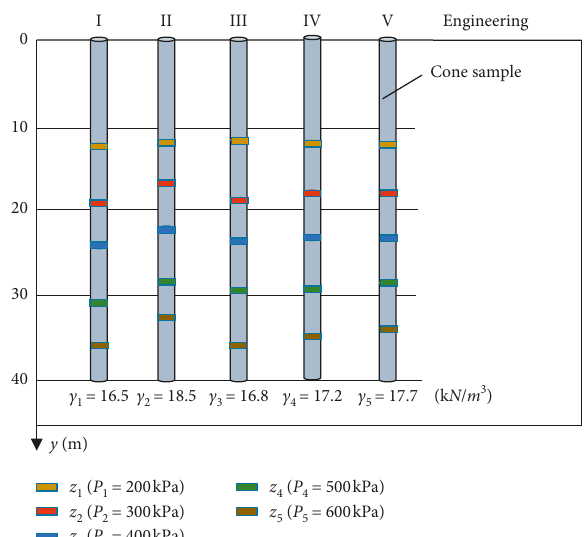
Figure 12: Depth of the calculation points for each core sample.